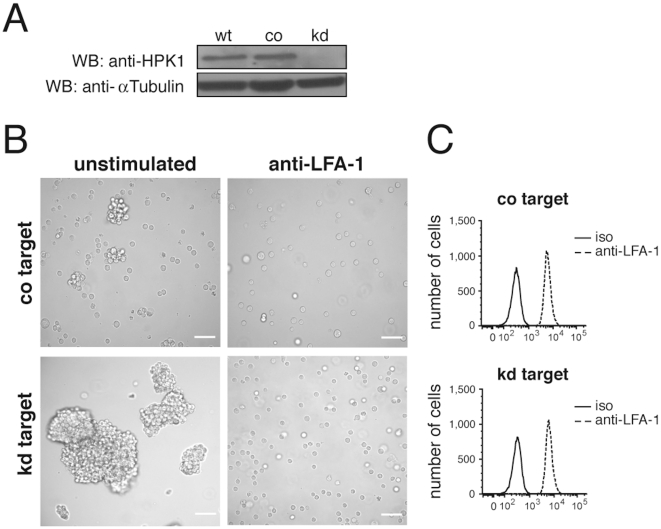
Homotypic aggregation of HPK1 knockdown Wehi 231 cells.(A) HPK1 protein expression in Wehi 231 wild type (wt), control (co) and knockdown (kd) cells determined by anti-HPK1 Western blotting. (B) Homotypic aggregation of Wehi 231 kd transfectants compared to transfection controls; cluster formation was blocked by adding anti-LFA-1 antibody [30 µg/ml] for 17 h into the culture medium (Zeiss Axiovert 135, scale bar: 50 µm). (C) Flow cytometric analysis (FACS Canto II) of Wehi 231 co and kd cell LFA-1 surface expression; iso, isotype control.